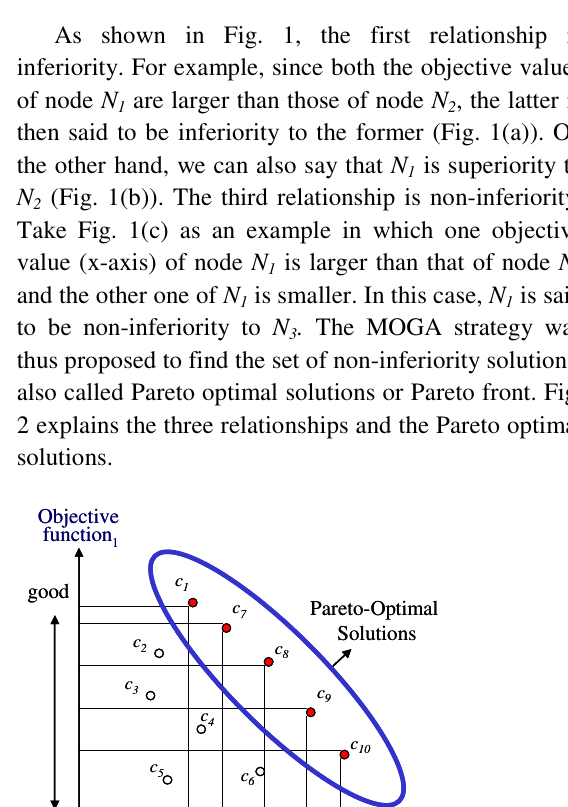
half the span. R denotes the membership function jk